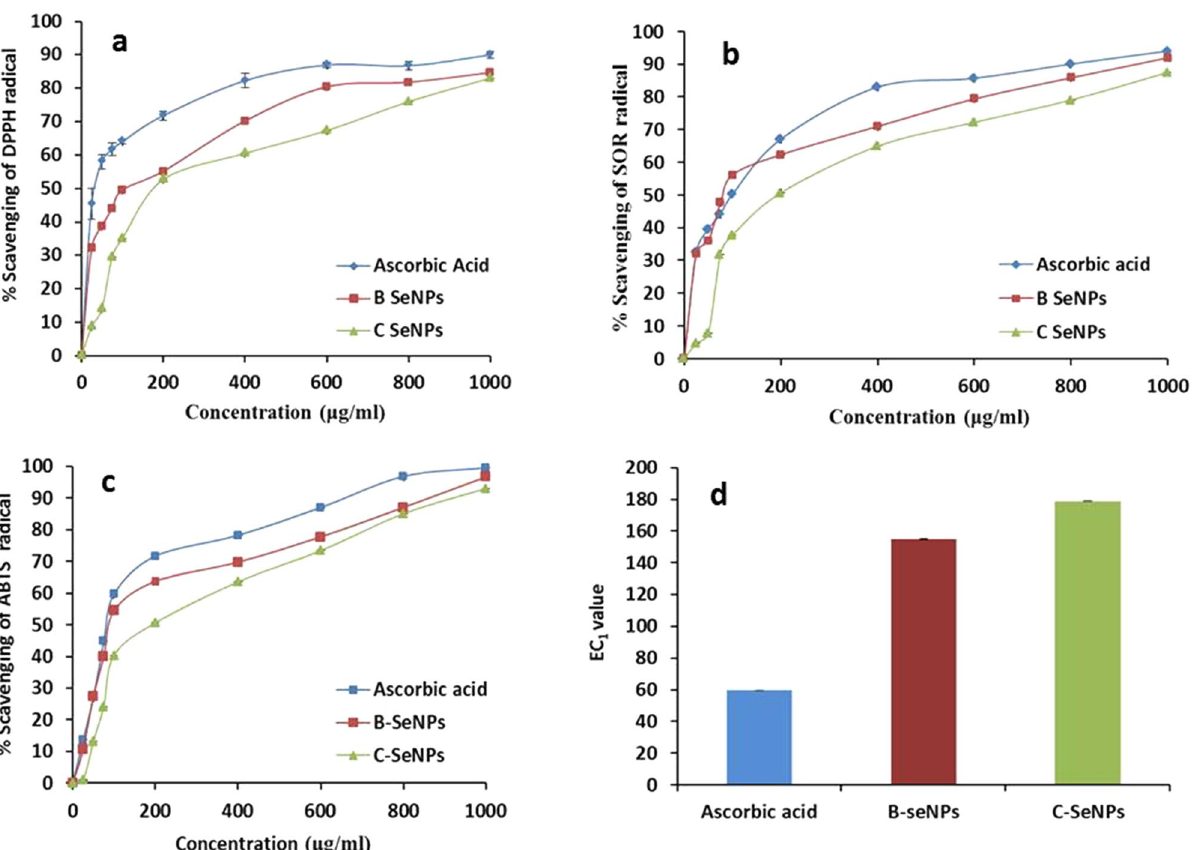
Figure 5. Comparative anti-oxidant assays of B-SeNPs and C-SeNPs ( a ) DPPH scavenging assay ( b ) SOR scavenging assay ( c ) ABTS assay ( d ) FRAP